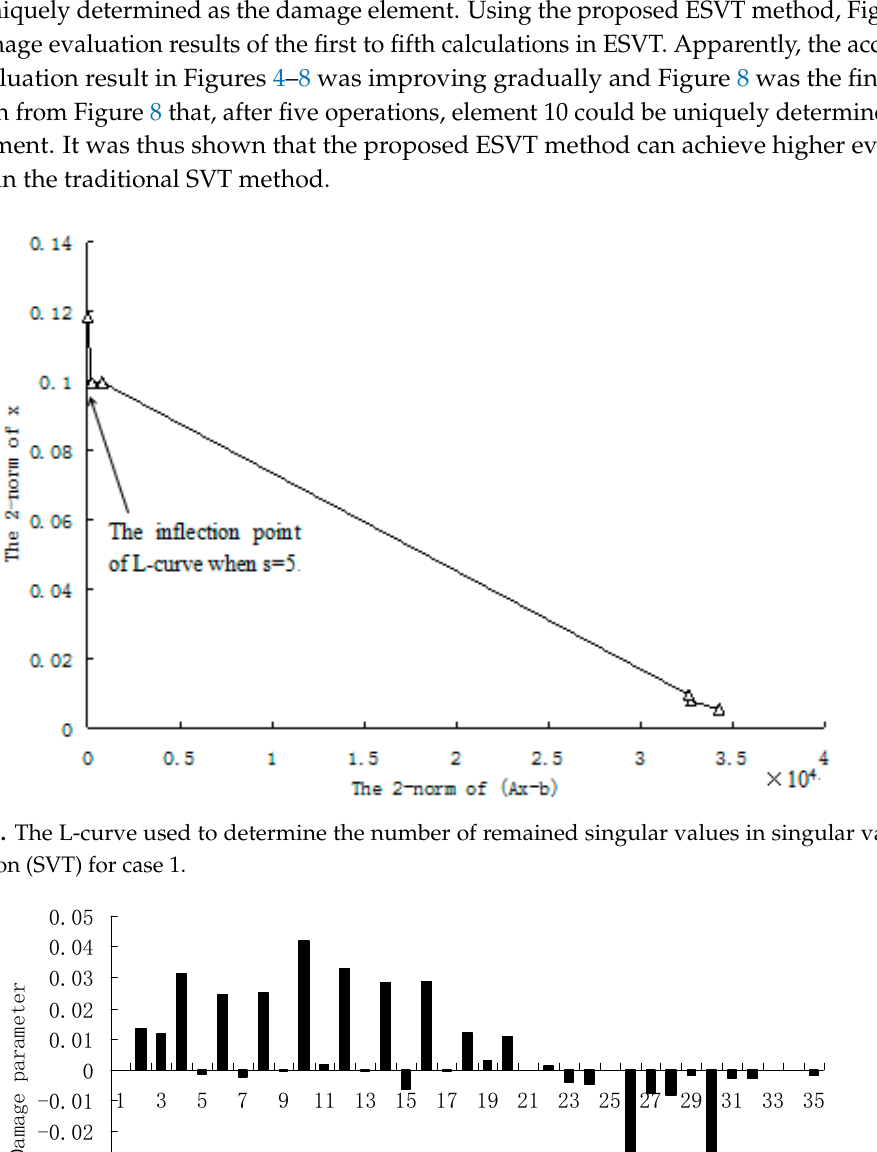
Figure 4. Damage evaluation result by the first computation of enhanced singular value truncation (ESVT) for case 1 (element 10 had 20% stiffness reduction). -0.04-0.0200.020.040.06 0.080.10.12 1